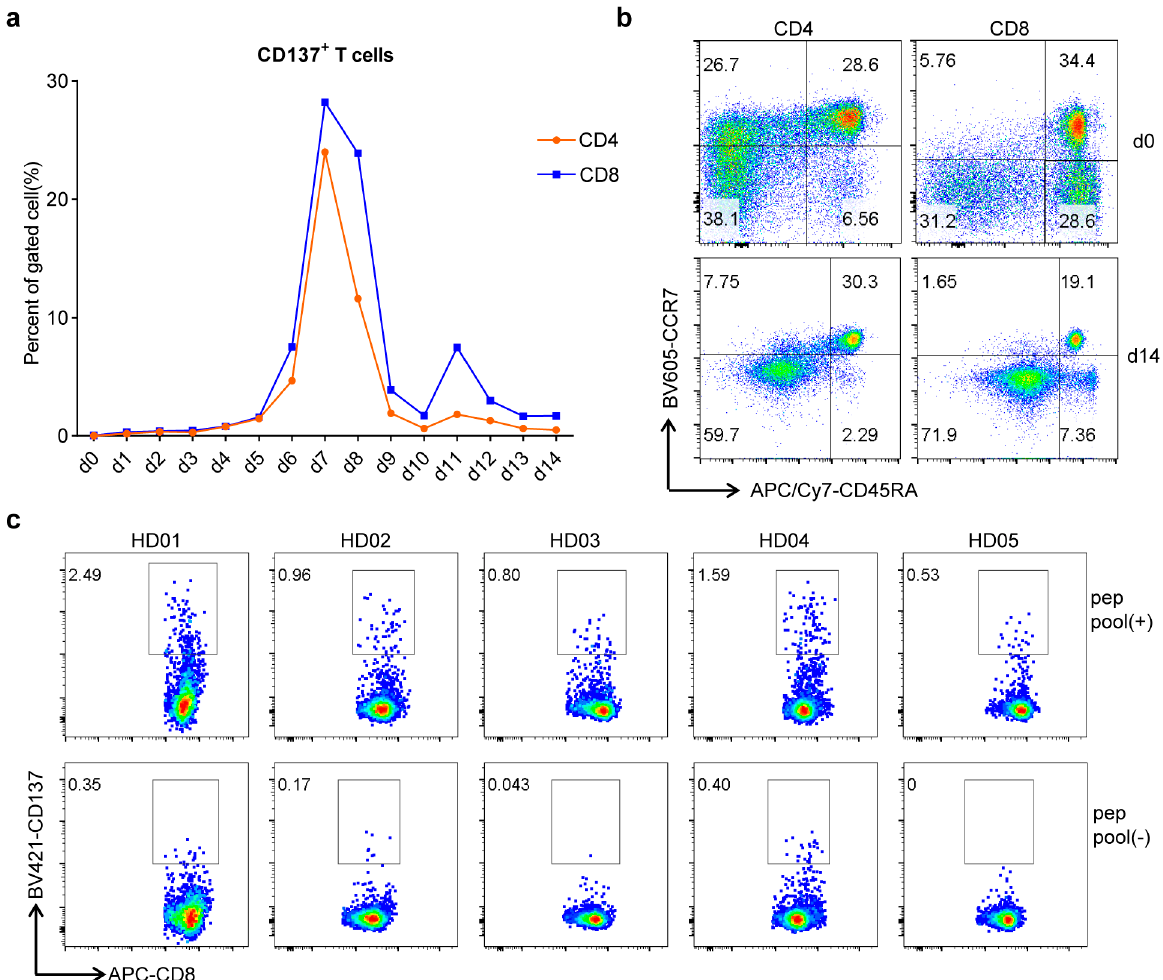
Figure 3. Fluorescence Activating Cell Sorter (FACS) of conserved antigen-specific CD8 + T cells from unexposed healthy donors. PBMCs of unexposed healthy donors were stimulated by culture with peptide pool in vitro for 2 weeks, for amplification of the peptide-specific T cells. ( a ) PBMCs from HD01 were cultured with peptide pool for stimulation with time range from 0 day to 14 days, for dynamic assay of T cell activation during the two-weeks culture. Each sample was col ‐ lected every day for T cell activation analysis. ( b ) HD01 samples of d0 and d14, corresponding to pre ‐ and post ‐ stimulation, were assayed for T cell phenotype by flow cytometer using CD45RA and CCR7 biomarkers. ( c ) Cells were re ‐ stimulated by co ‐ culture with peptide pool loaded PBMCs overnight, and CD3 + CD8 + CD137 high T cells were sorted as conserved anti ‐ gen ‐ specific CD8 + T cells by FACS.